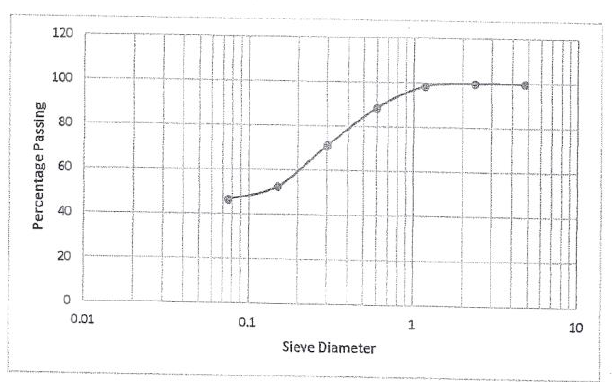
Figure 6: Graph of Dry Density against Average Moisture Content for